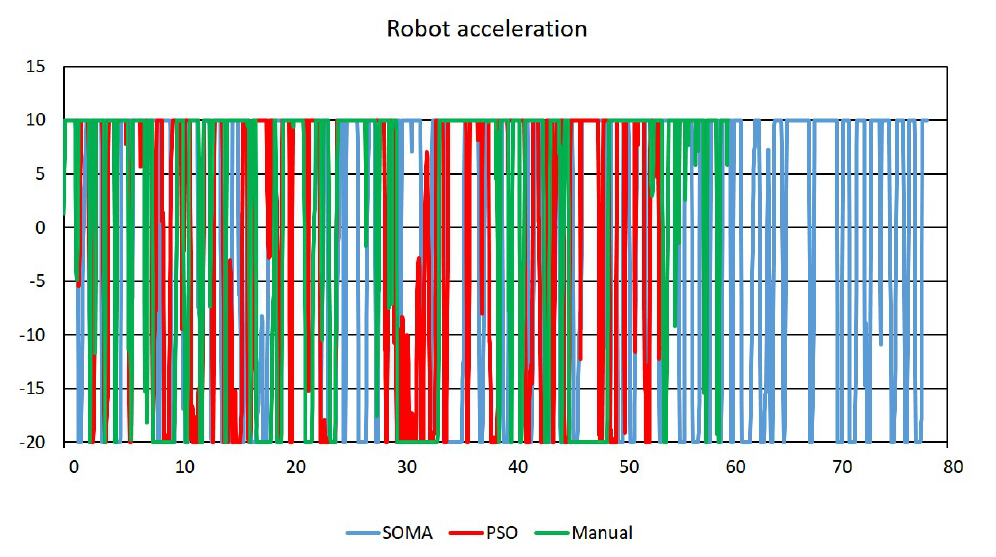
Figure 14. Comparison of robot accelerations for FCMs designed with help of PSO, SOMA, and man- ual